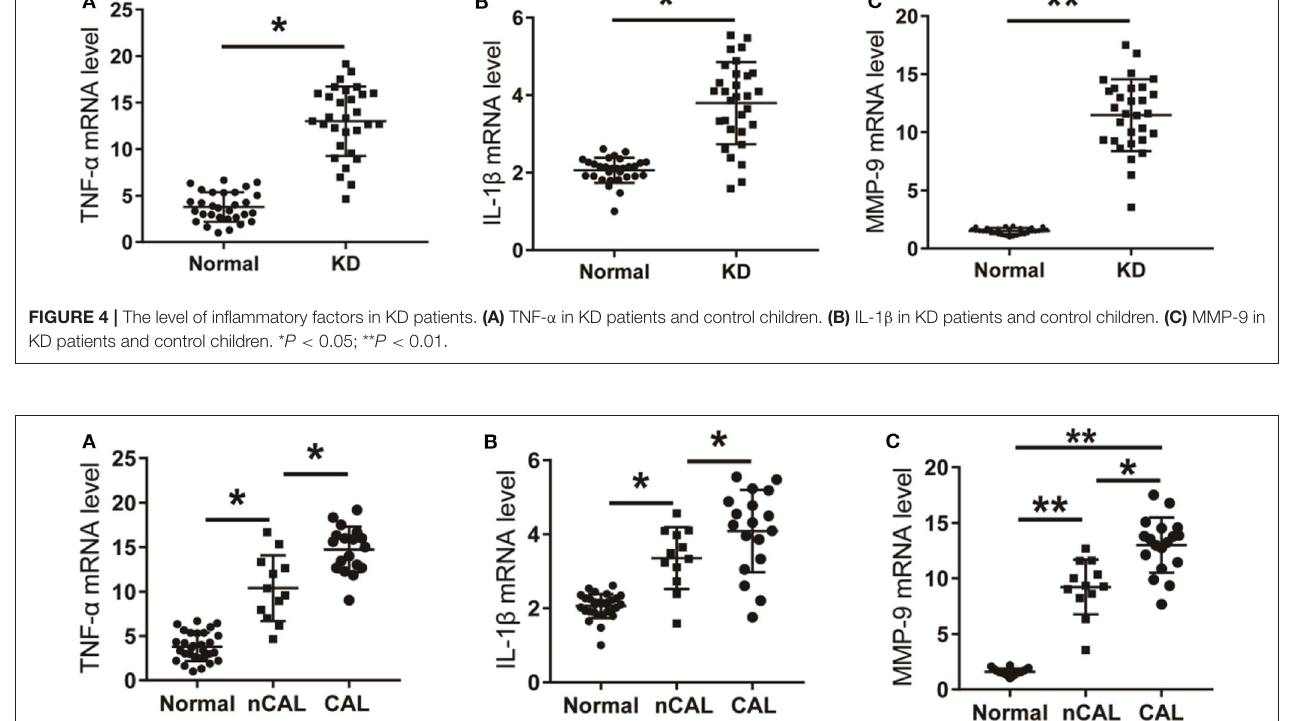
Frontiers in Pediatrics |